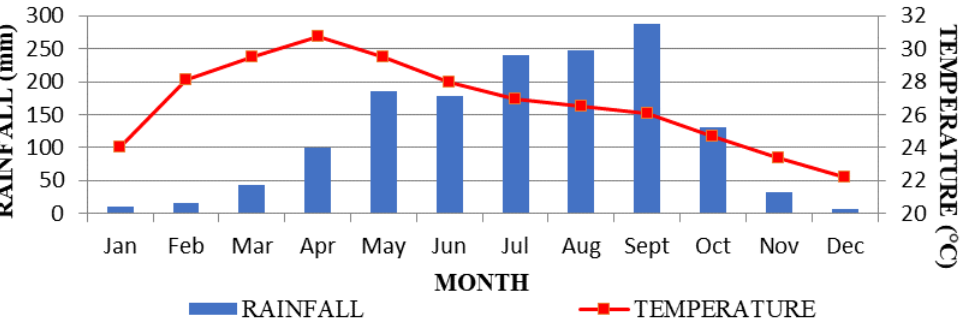
Figure 2. Average monthly rainfall and temperatures for the study area from 2004 to 2015.